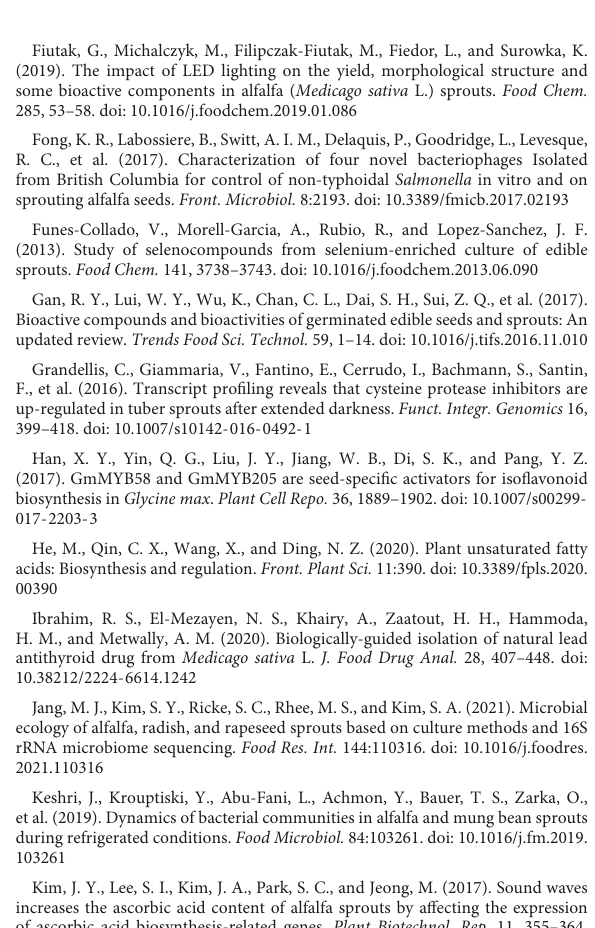
SUPPLEMENTARYFIGURE5 KEGG pathway analysis of DAMs in alfalfa seeds and sprouts. (A) The number of up- and downregulated DAMs in different classes in green alfalfa sprouts vs. soaked alfalfa seeds. (B) The number of up-